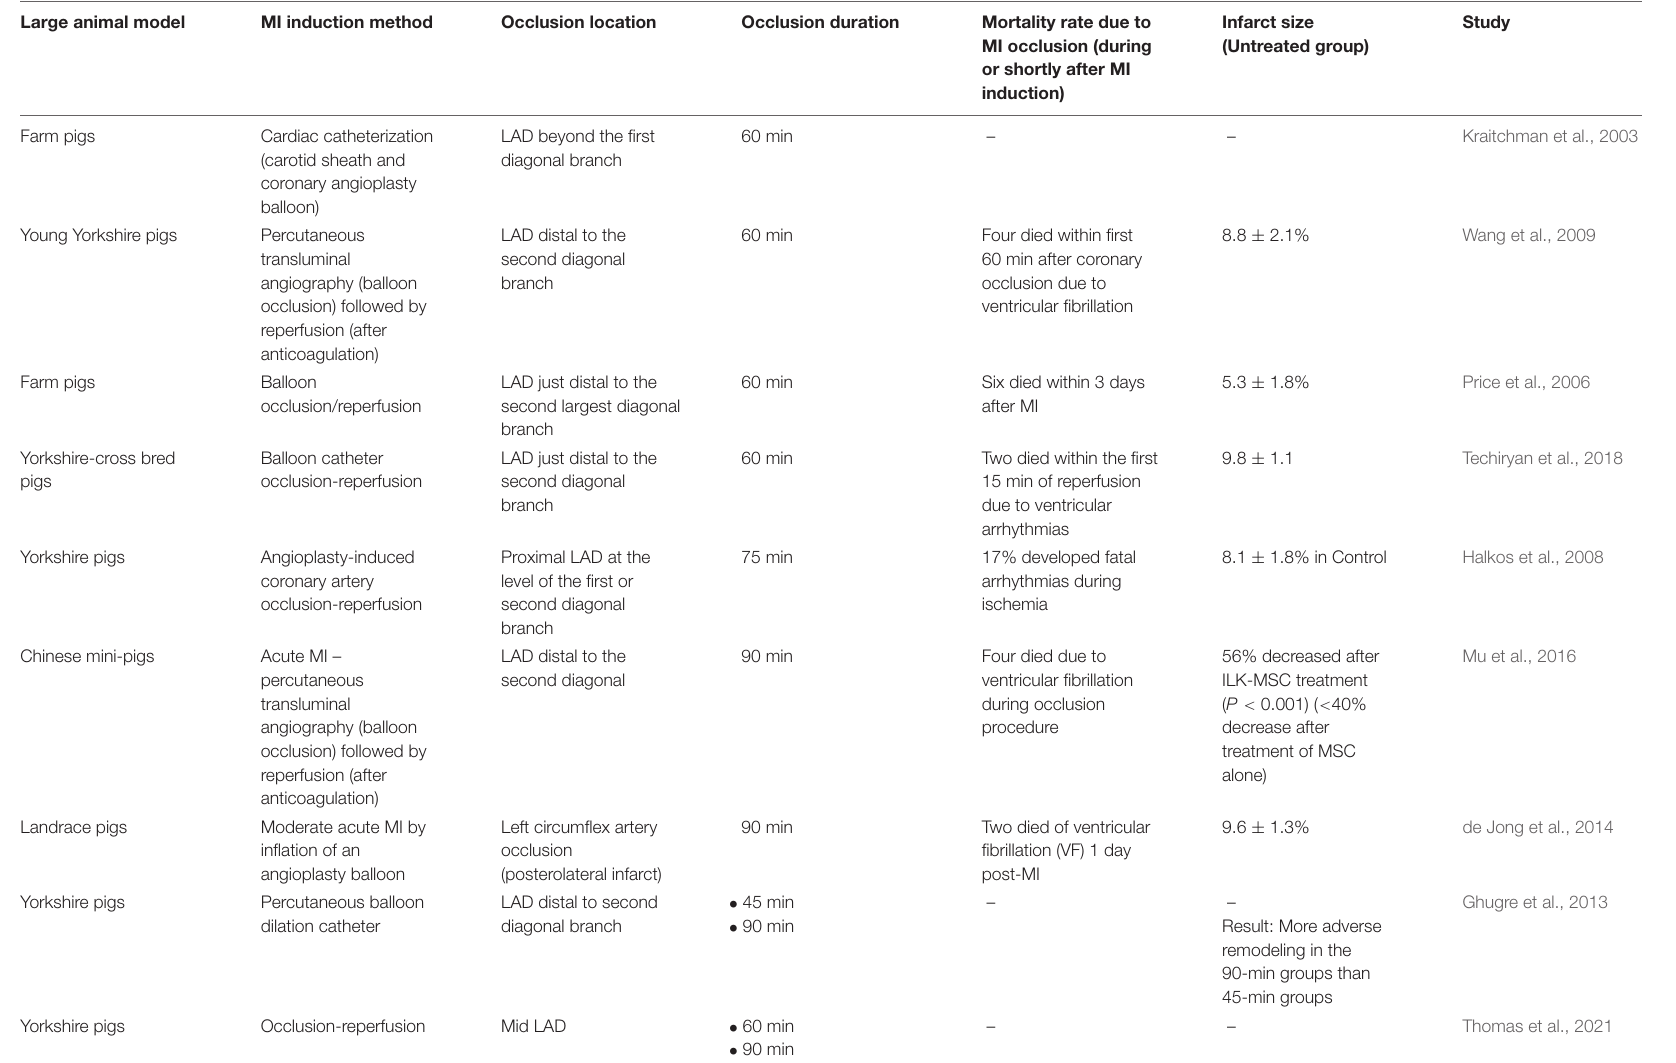
TABLE 3 | Variations in occlusion duration in catheter-based MI